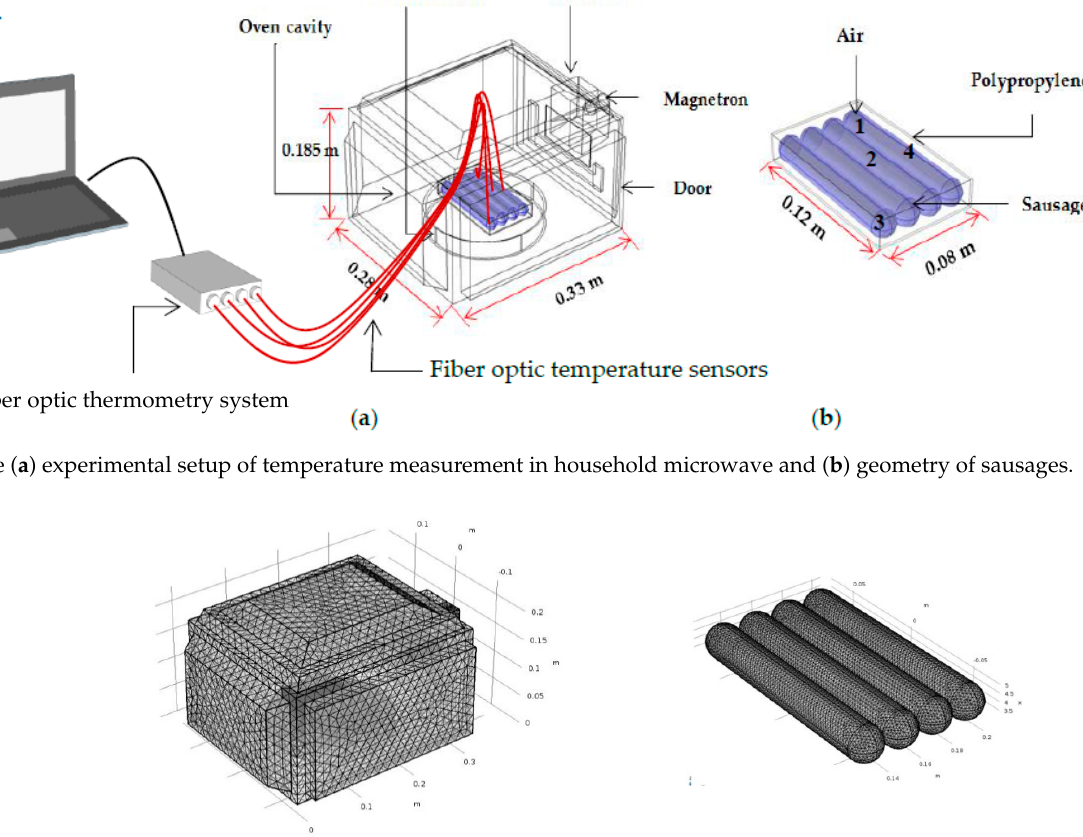
( a ) ( b ) ( a ) ( b ) Figure 2. Element meshing of ( a ) microwave and ( b ) sausages domain. Figure 2. Element meshing of ( a ) microwave and ( b ) sausages Figure 2. Element meshing of ( a ) microwave and ( b ) sausages domain.